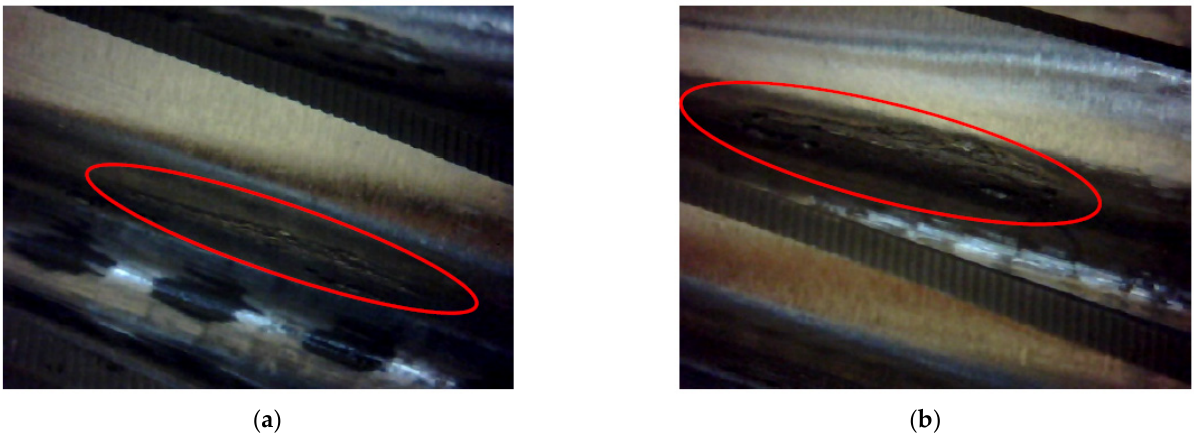
Figure 16. Worn gear of the low-speed stage in GB2. ( a ) Wear occurred on the pinion; ( b ) Wear occurred on the gear.